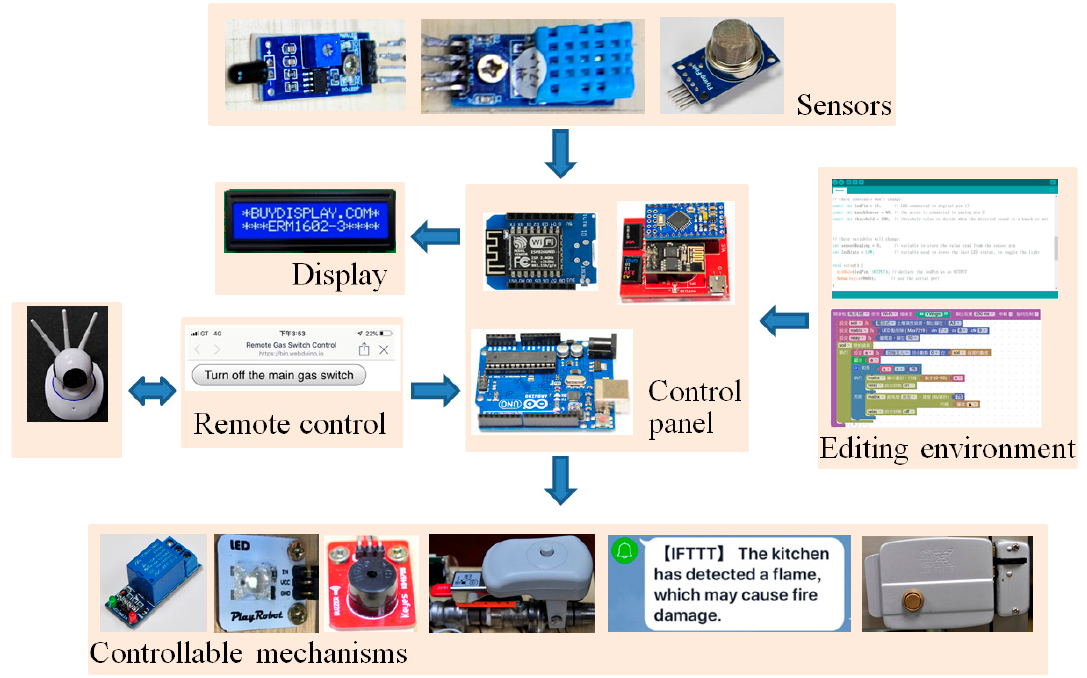
Figure 13. Architecture of the smart kitchen fire prevention system.